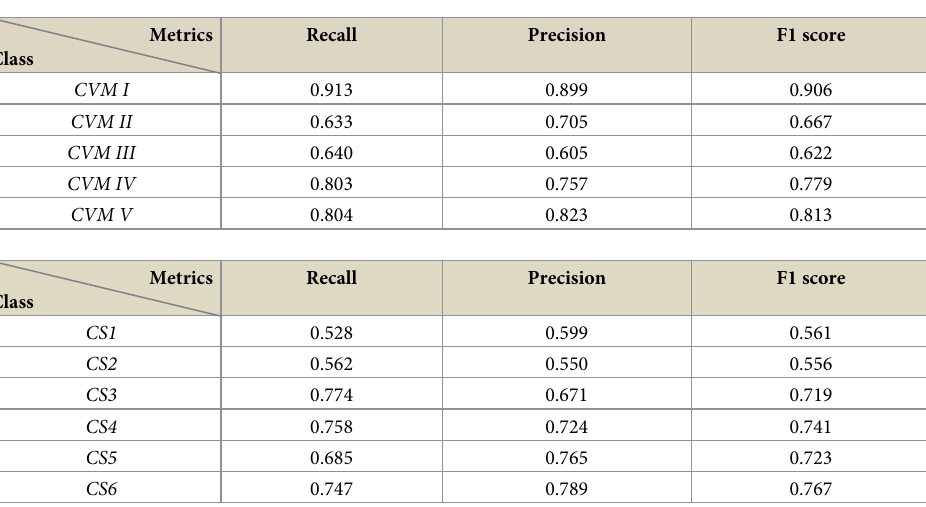
Table 3. Performance metrics of the classes for both classification task. Recall, Precision and F1 Score are calcu- lated for every class in both classification tasks. 5-stage classification (a) contains higher values than 6-stage classifica- tion